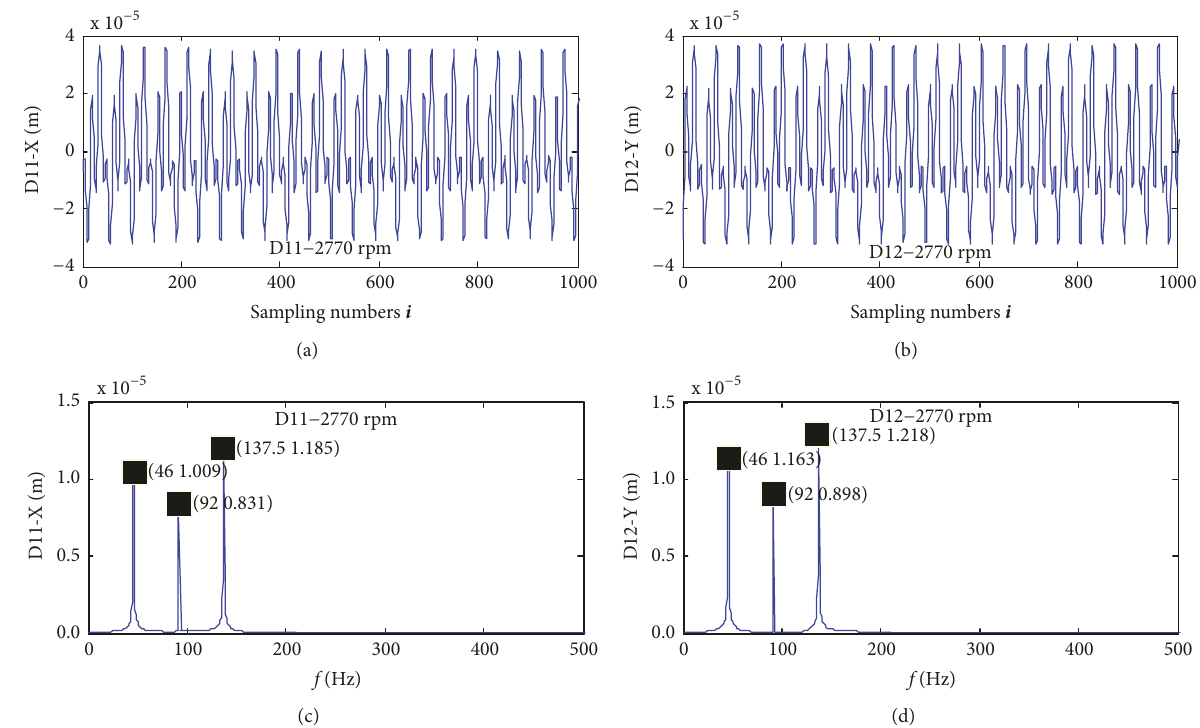
Figure 18: Extracting the time and frequency spectrums of the first three frequencies of D11 and D12 by PCA algorithm. (a) The time domain of D11. (b) The time domain of D12. (c) The frequency spectrum of D11. (d) The frequency spectrum of D12.